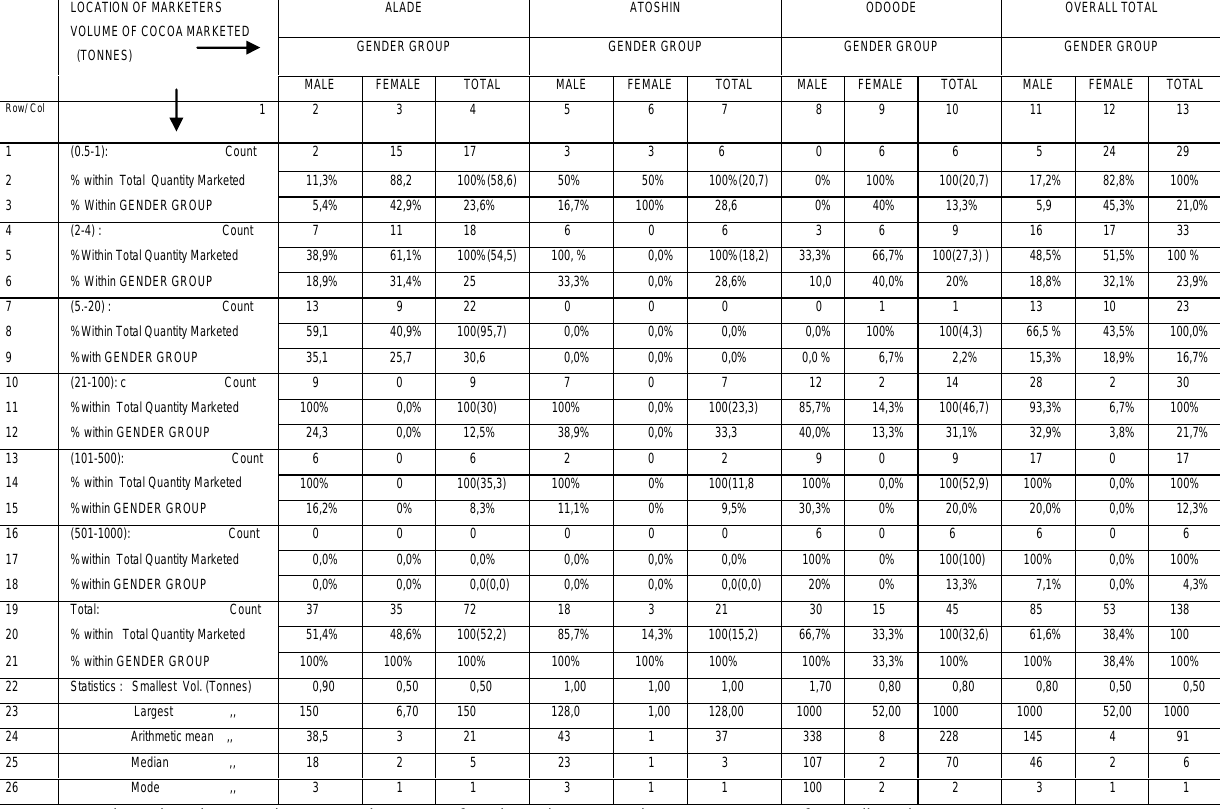
Table 5: Distribution of statistics of volume of cocoa marketed by gender and location: Ondo State of Nigeria, 2000/2001